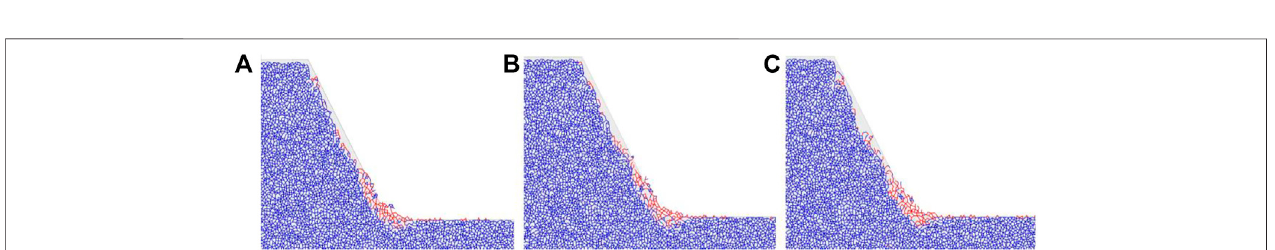
FIGURE 10 | Morphology under different scouring velocities of the 60 ° slope. (A) 0.1, (B) 0.15, and (C) 0.2 m/s.